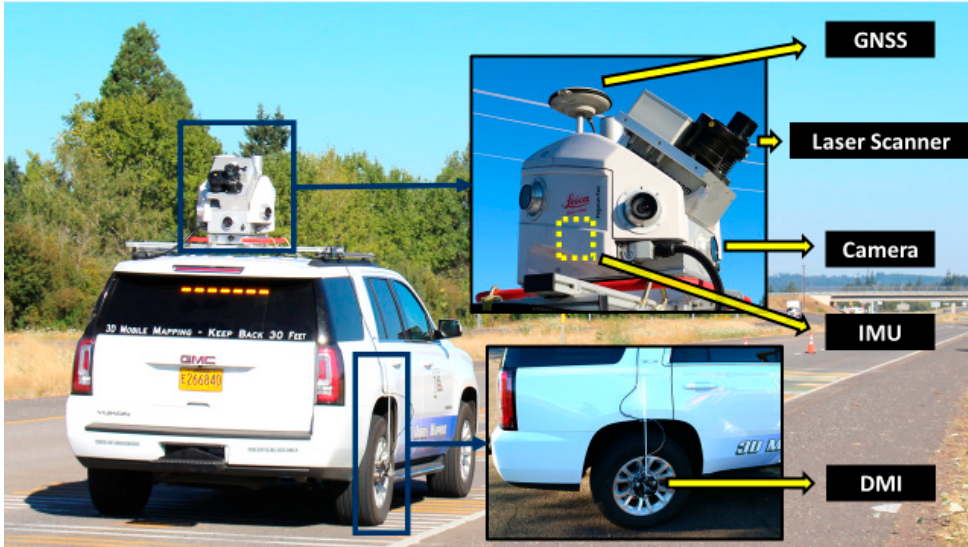
Figure 2. An example of an MLS system (owned by the Oregon DOT) and its components (Leica